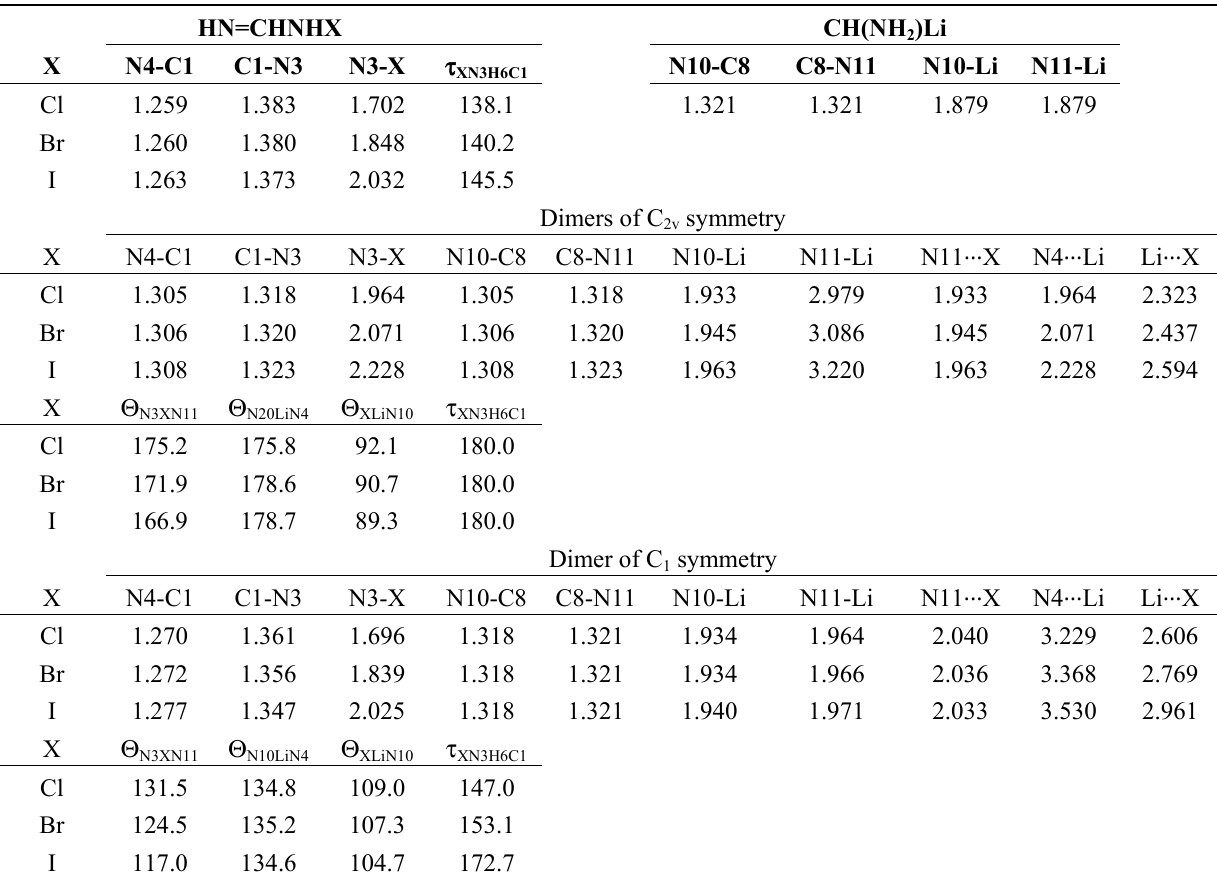
)Li, anddimers at 2 2